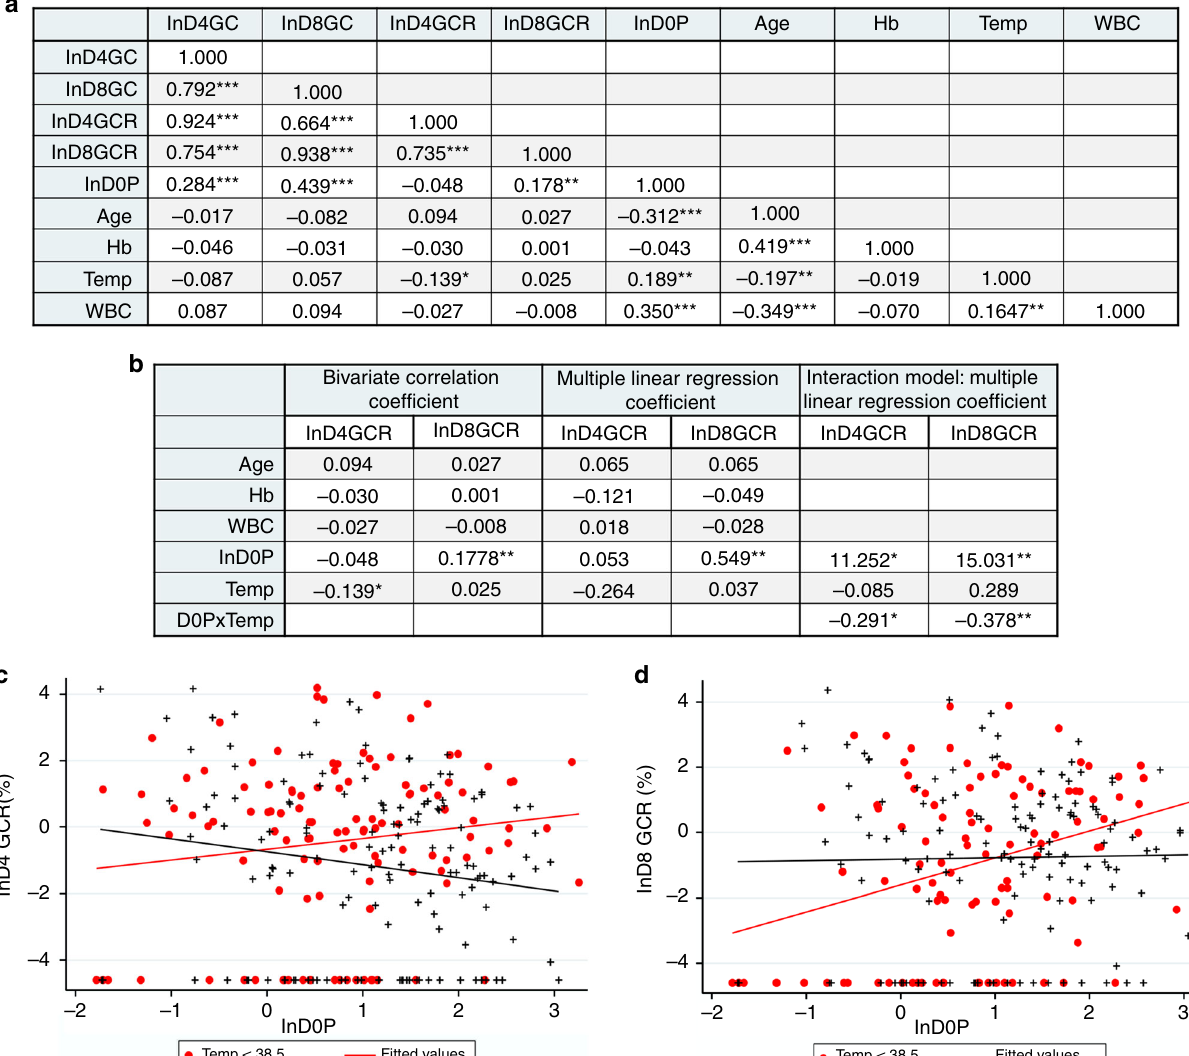
(Fig. 2a). To determine whether the signi fi cant associations with D4 and D8 GCR persist after adjusting for other variables, we performed a multiple linear regression analysis (Supplementary Table 2). D0P remains positively associated with D8 GCR as well as D4 and D8 gametocytemia (D8GCR p = 0.002 and D4GC & D8GC p < 0.001) and there is still a negative association between reach p < 0.050 suggesting the contribution of the other factors. To further investigate the relationship between GCR and D0P and D0 temperature, we tested for an interaction between natural log normalized D0P and D0 temperatures by regression analysis using a continuous temperature model (Supplementary Table 3).